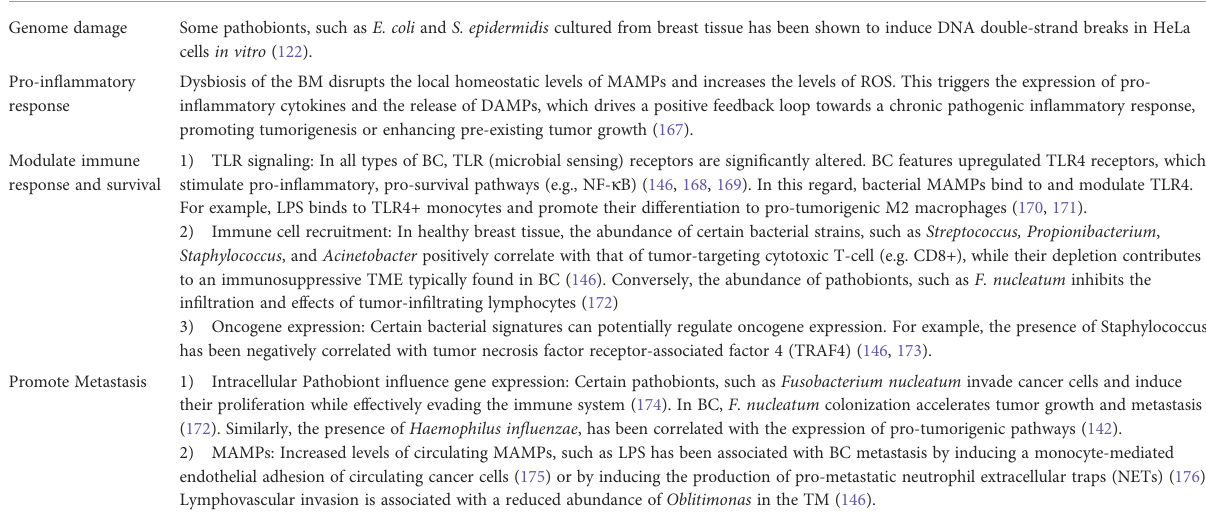
TABLE 2 Microbial contributions to oncogenesis and tumor